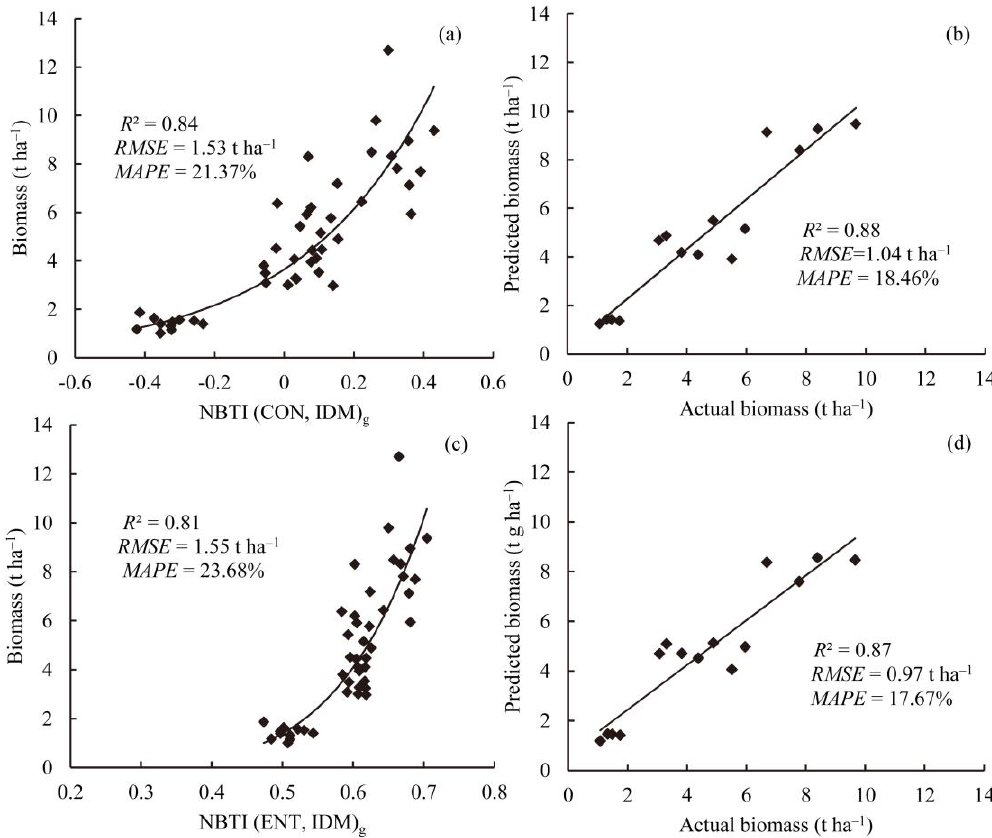
Figure 5. Results when using NBTI (CON, IDM) g and NBTI (ENT, IDM) g to estimate the biomass. ( a ) Calibration results for NBTI (CON, IDM) g , ( b ) validation results for NBTI (CON, IDM) g , ( c ) calibration results for NBTI (ENT, IDM) g , and ( d ) validation results for NBTI (ENT, IDM) g .